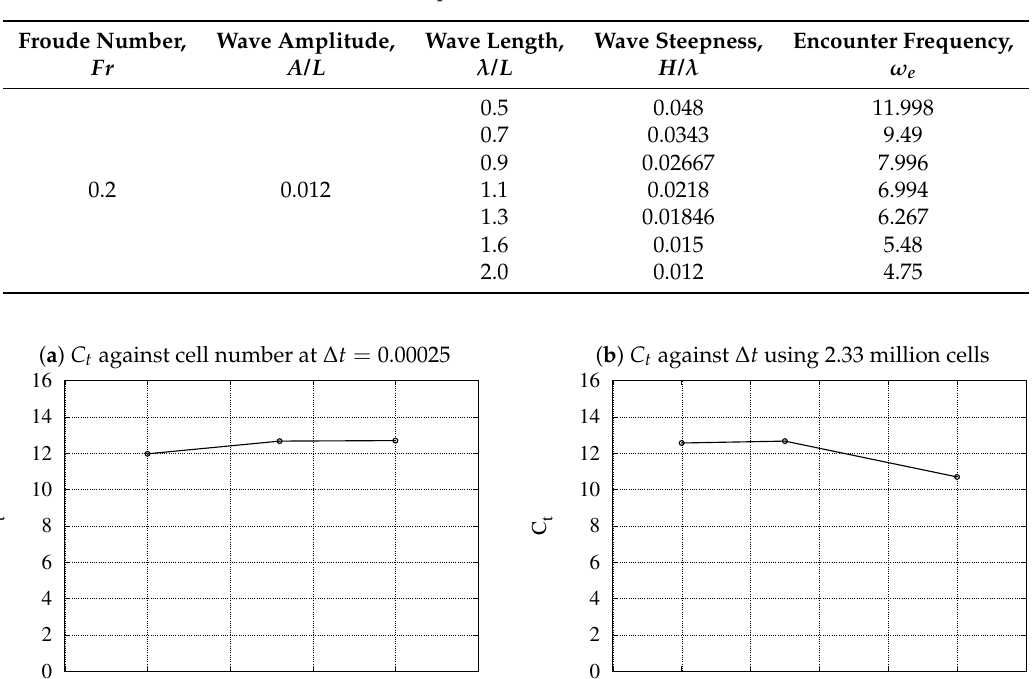
Table 2. Wave parameters for the simulations.